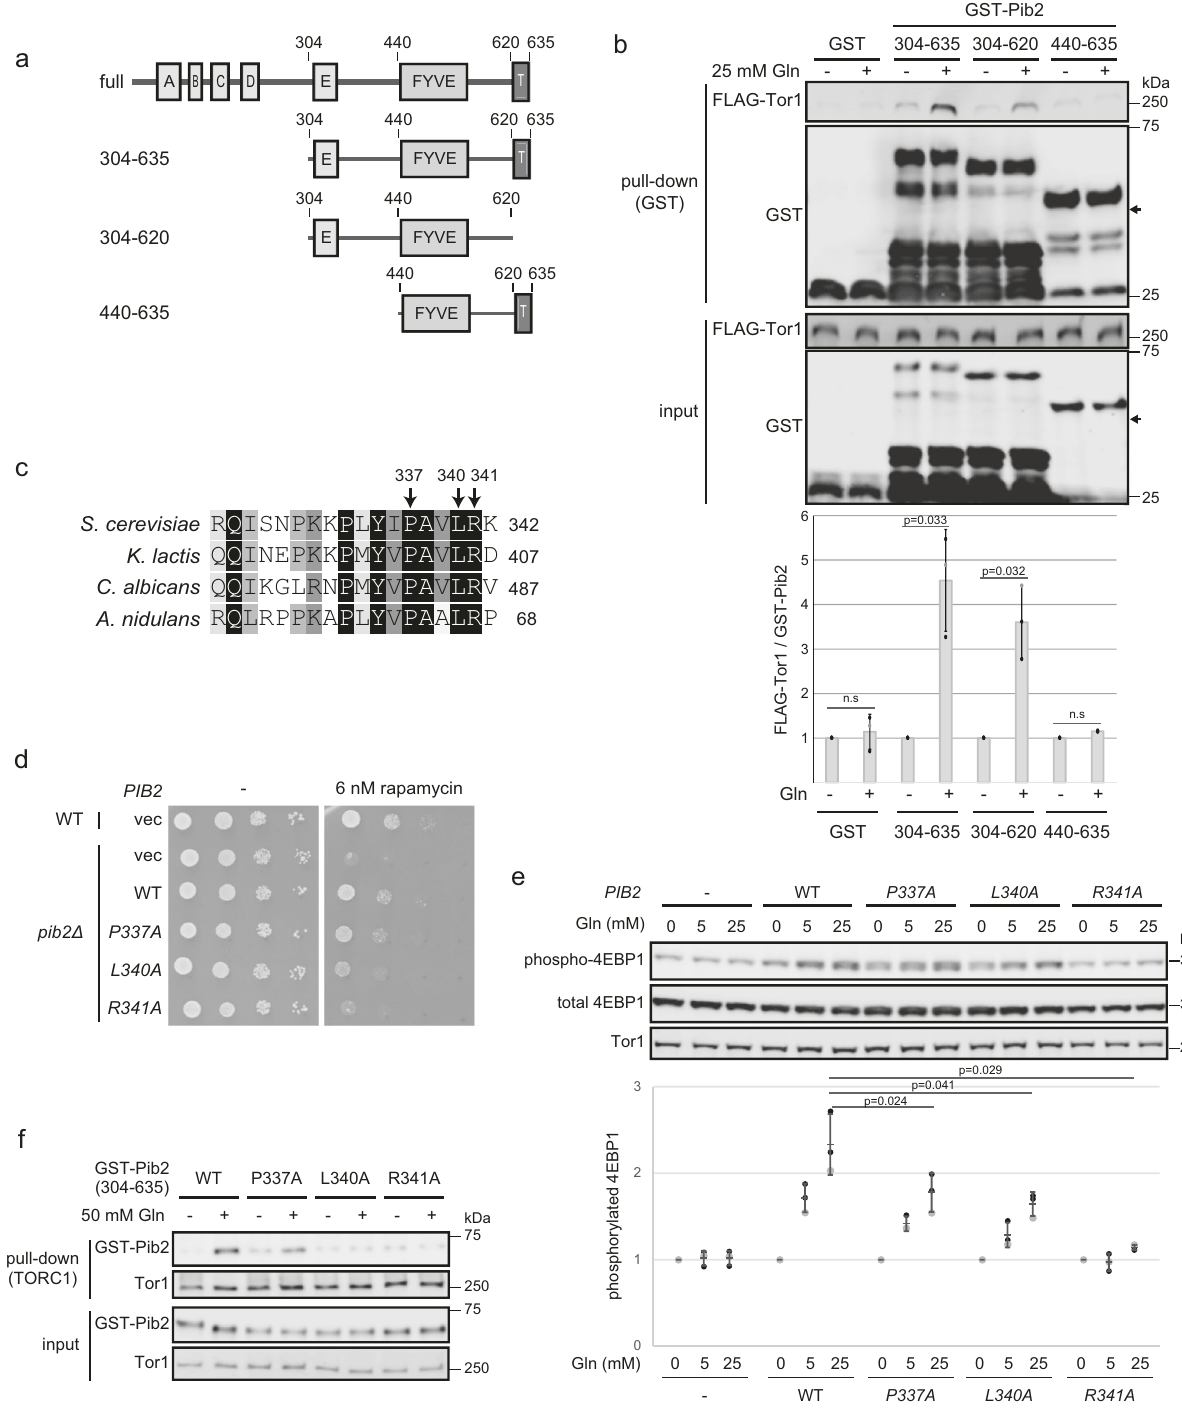
Hyperactivating PIB2 mutations are clustered in the conserved tail motif . Since puri fi ed Pib2 interacts with puri fi ed TORC1 (Figs. 1f, g, and 2f), Pib2 is likely to directly activate TORC1.